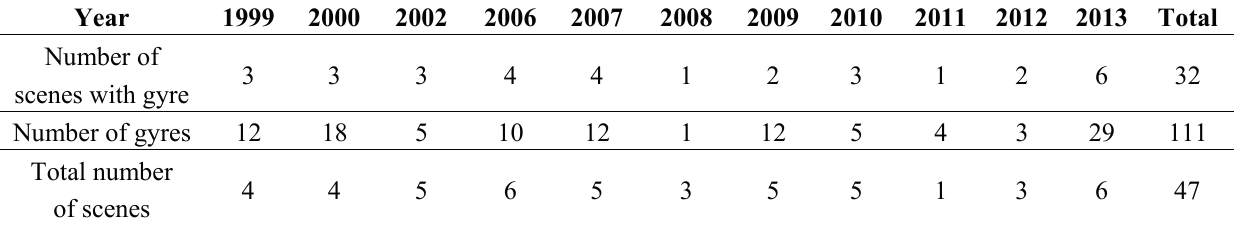
Table 6. Number of gyres found in each year from 1999 to 2013 in Teshekpuk Lake. (Note no gyres were found in 4 scenes in 2001, 2003, 2004 and